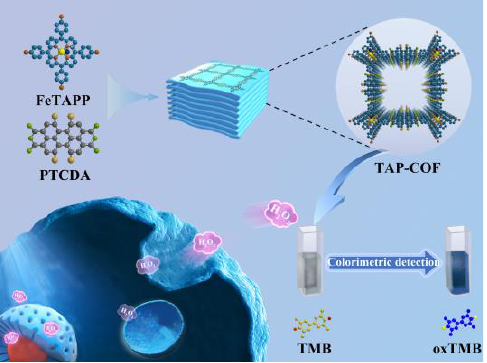
Scheme 1. Diagrammatic drawing for the synthesis of TAP-COF and in situ detection of H 2 O 2 released from MCF-7 cells.